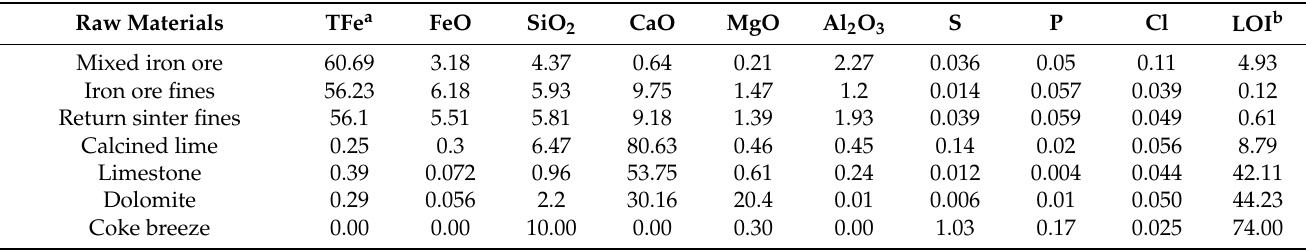
Table 2. Chemical compositions of raw materials (mass, wt.%). Reprinted with permission from Elsevier, 2022